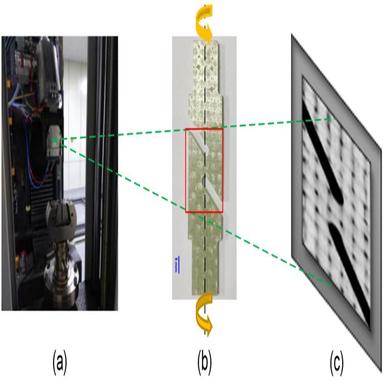
The computer tomography equipment: (a) X-ray source; (b) Sample; (c) Planar detector.